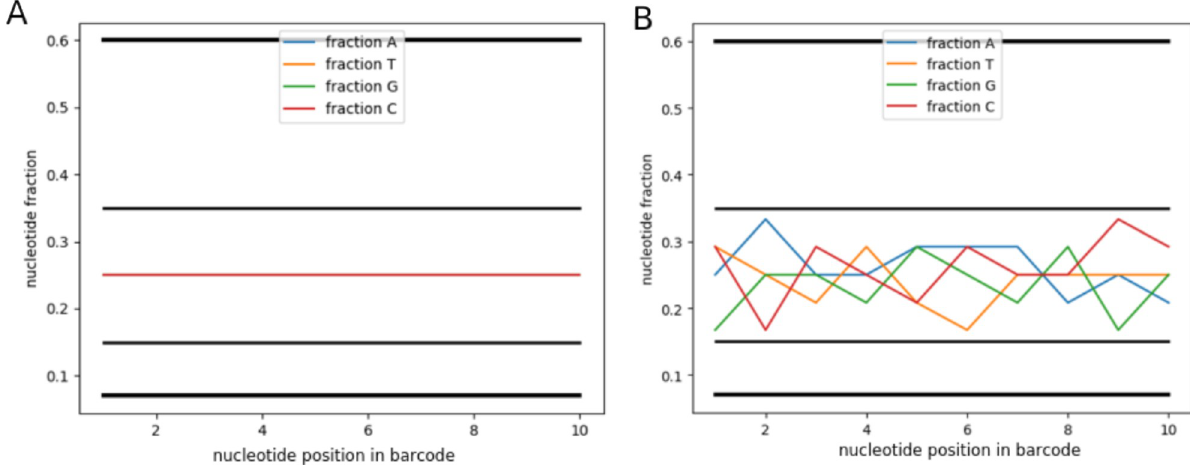
Fig 7. Example of the NUCLEOTIDES FRACTION script. A–for sets 1–10, the proportions of each nucleotide at each bar code position are equal to 0.25. B–for set 11, the proportions of each nucleotide vary within certain limits. Bold horizontal lines—lite criterion, thin lines—strong criterion.